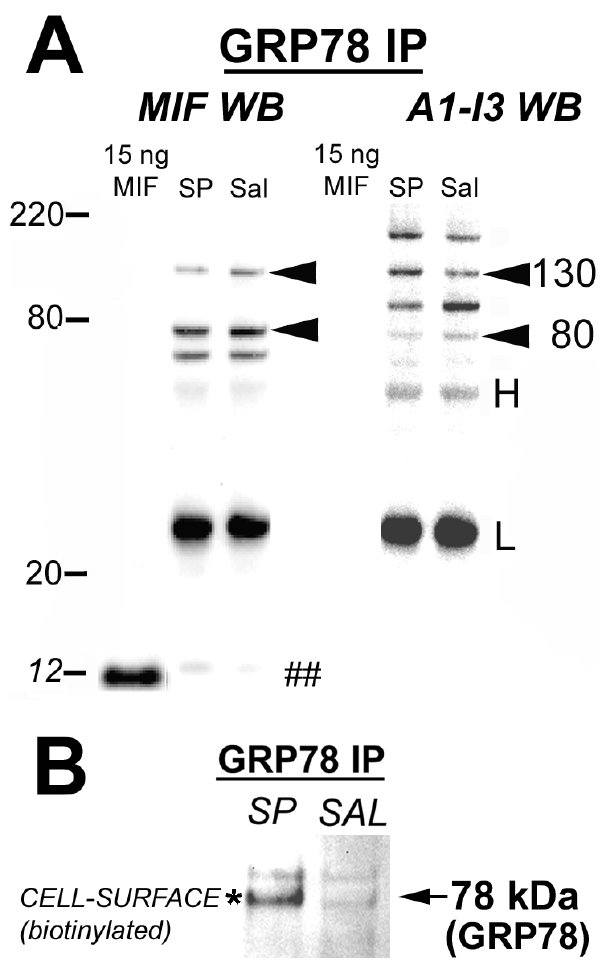
Figure 2. GRP78-MIF complexes in the bladder. A) Representative results of GRP78 ‘‘pull-down’’ experiments where GRP78 complexes were isolated from bladder homogenates by immunoprecipitation and then MIF (left side of figure) or A1-I3 (right side of figure) western blotting was carried out to identify complexes. Recombinant MIF was loaded (1 st lane) as positive control. Note that GRP78-MIF complexes (marked by ## at 12 kDa, lane marked Sal=Saline) increased after substance P treatment (lane labeled SP). A1-I3 western blotting